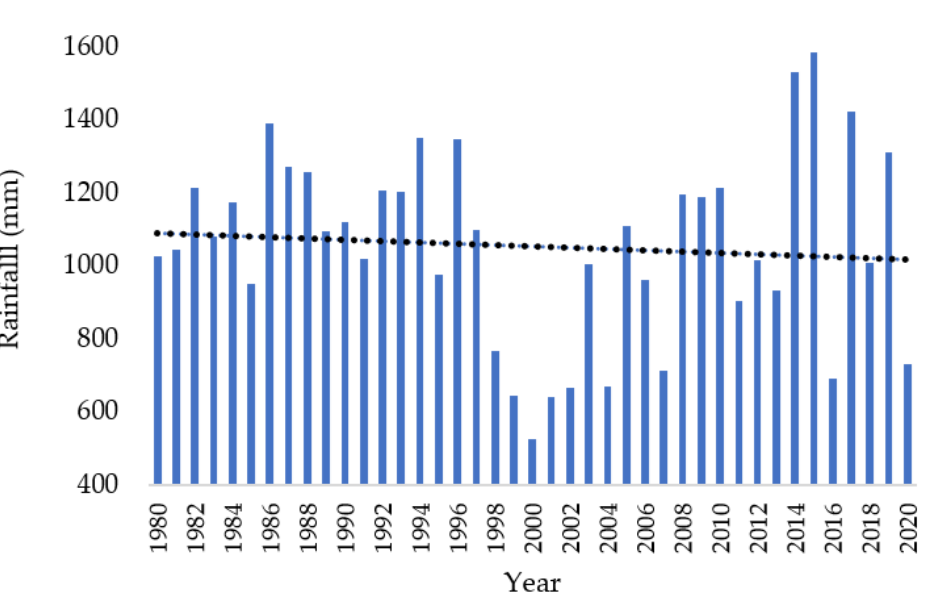
Figure 7. Descriptive statistics of weather parameters viz., Maximum and Minimum temperature and rainfall of location Kokernag.